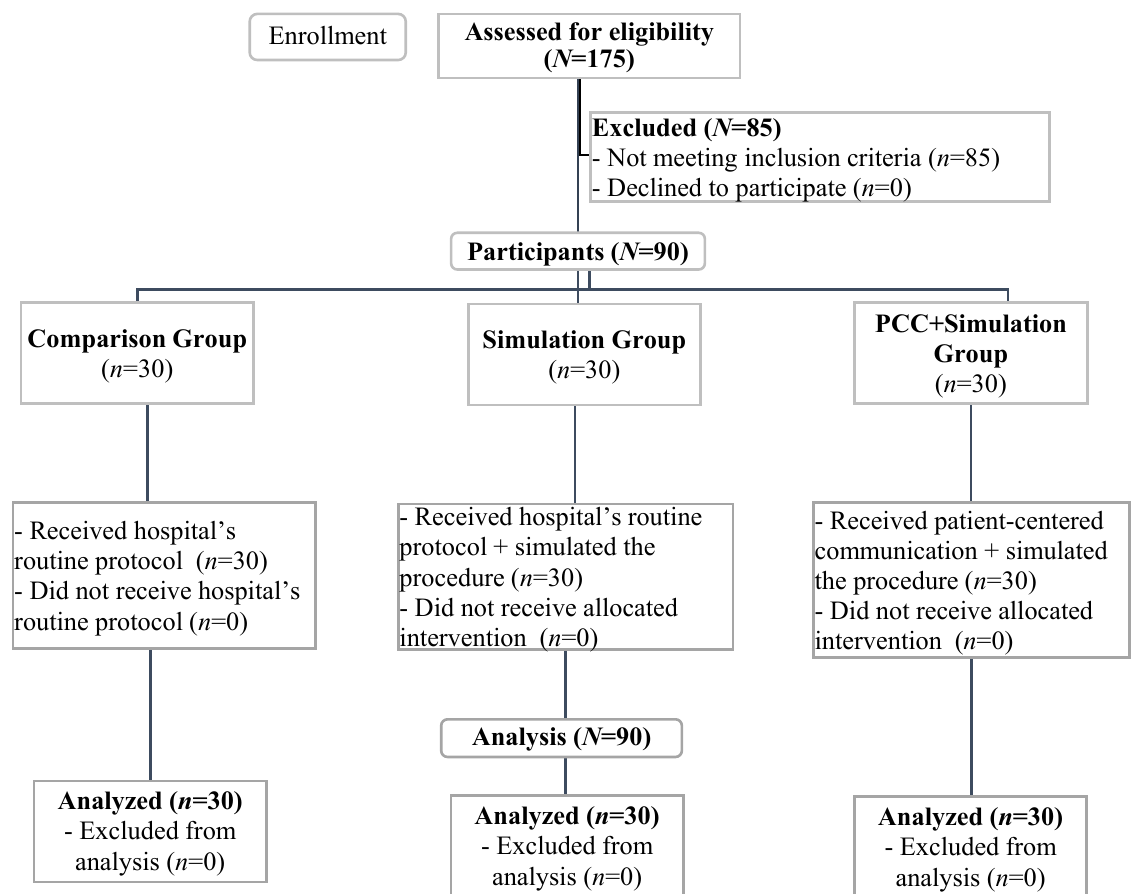
Figure 1. Flow diagram of enrollment, eligibility screening, and analysis.